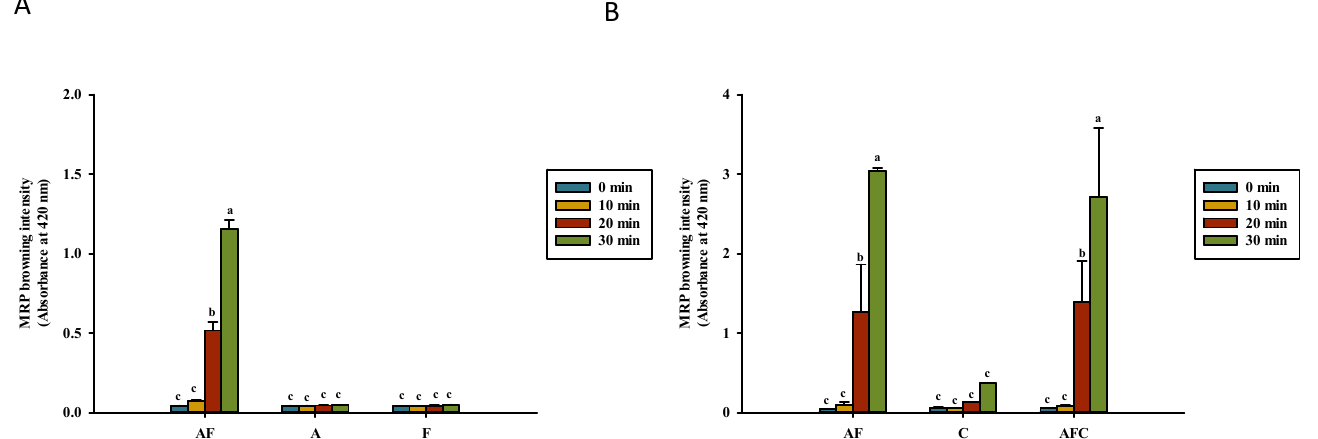
Figure 2. Brown color development (OD 420 ) of Maillard reaction product (MRP) for various groups upon heating in ( A ) water and ( B ) acetic acid. AF, asparagine and fructose; A, asparagine; F, fructose; C, chitosan; AFC, asparagine, fructose, and chitosan. Data represent the means of three replicates, and error bars indicate standard deviation. Bars followed by a common letter are not significantly different according to the Dunn’s test at the 5% level of significance.